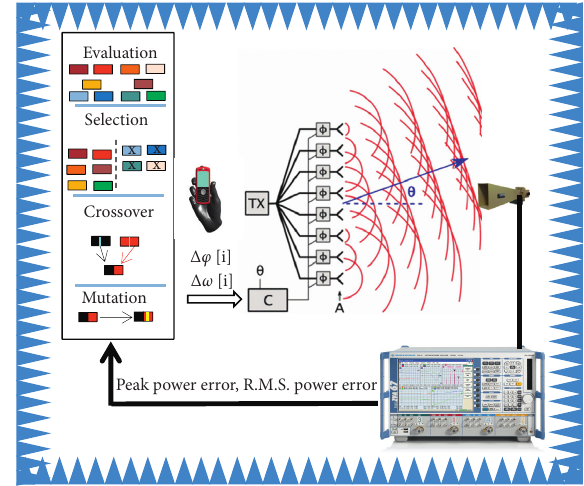
Figure 2: Setup of GA for far-field calibration of massive MIMO system in an anechoic